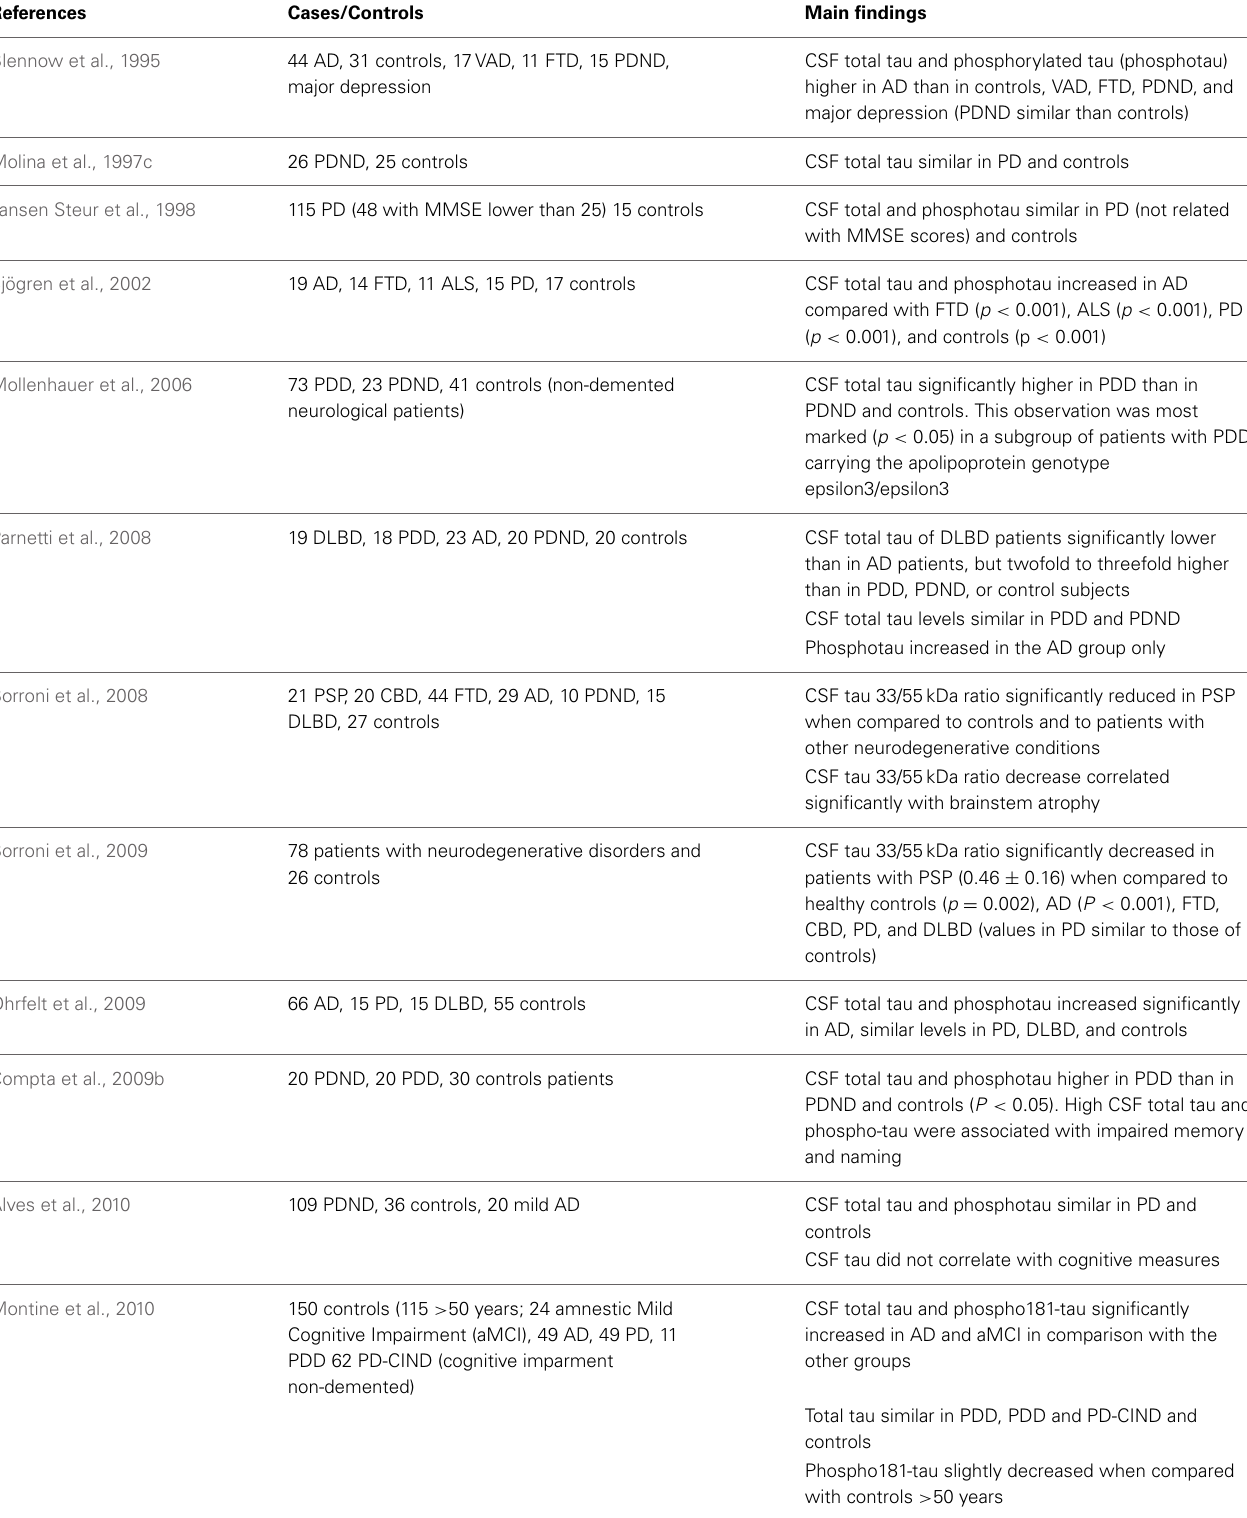
Table 4 | Results of studies on CSF tau and phosphotau levels in PD, other parkinsonian syndromes and